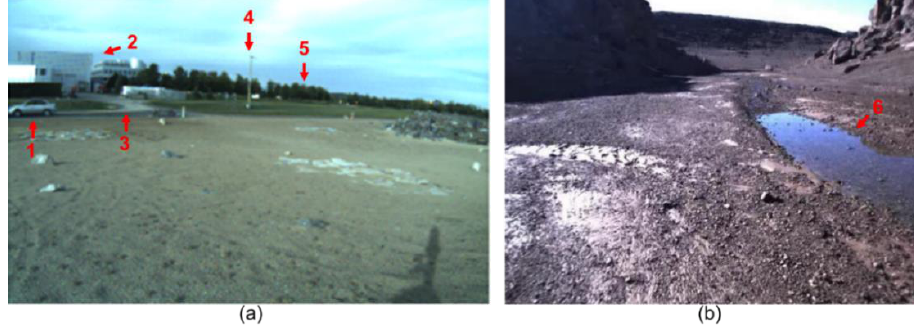
Figure A3. The example image from the other two planetary datasets. ( a ) and ( b ) refer to the image form [50,55], respec- tively. “1”, “2”, “3”, “4”, “5”, and “6” refer to irrelevant targets of vehicle, road, buildings, lamp, planet, and stagnant water.